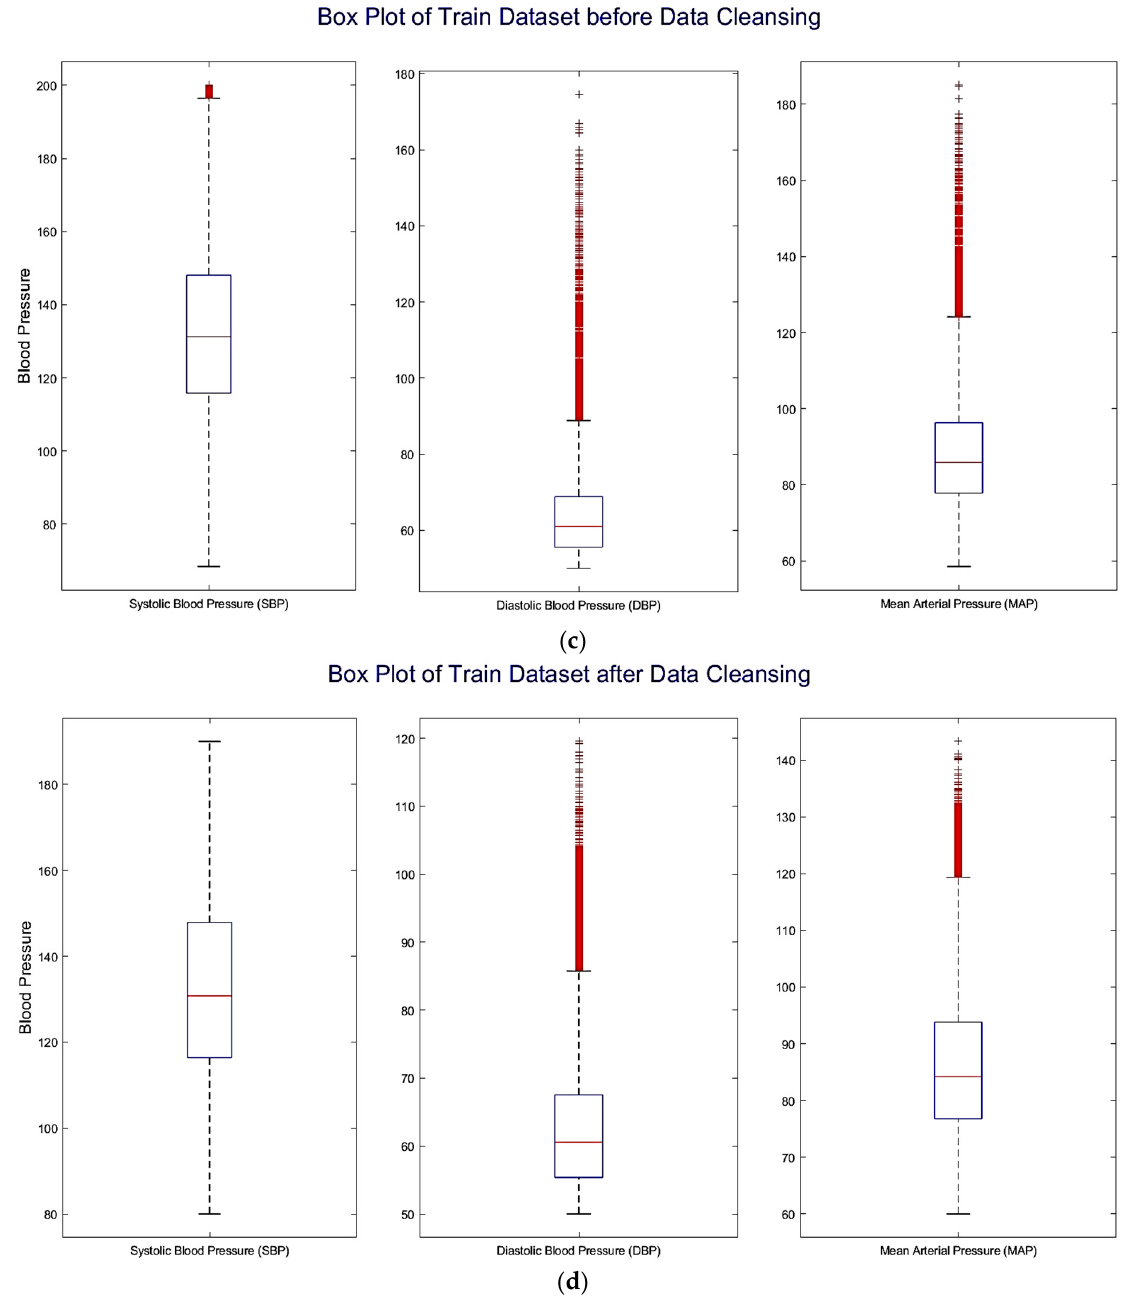
Figure 3. Histogram ( a , b ) and box plot ( c , d ) of systolic blood pressure (SBP), diastolic blood pressure (DBP), and mean arterial pressure (MAP) of signals in the training set before ( a , c ) and after ( b , d ) data cleansing, respectively.